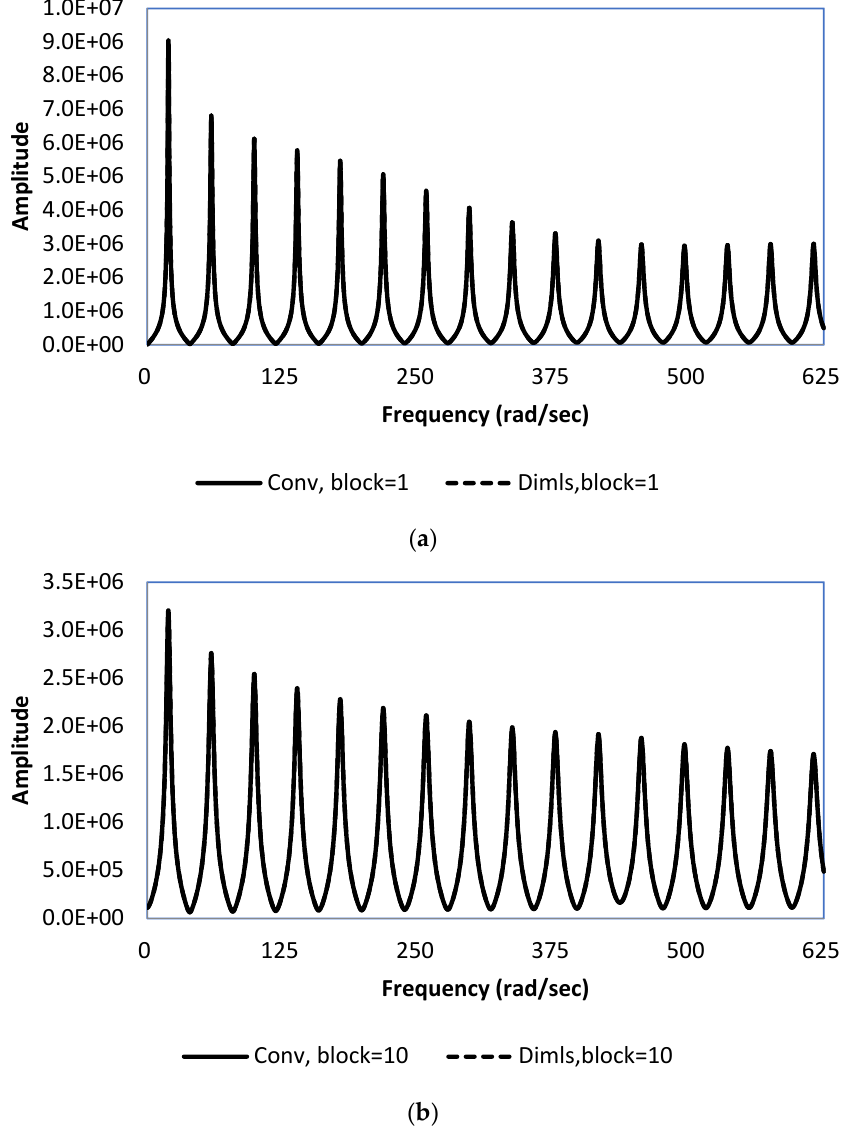
Figure 2. Distributions of impedance amplitudes of conventional formulation and MDBF of the frequency ‐ dependent friction model for partial blockage with one ( a ), and ten ( b )